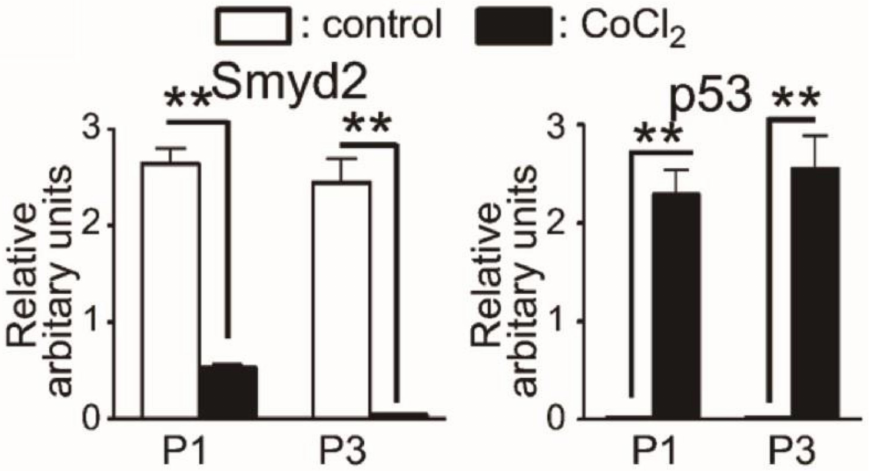
Figure 6. Cardiomyocytes, treated with CoCl2 to induce apoptosis, demonstrated downregulation of SMYD2 and accumulation of p53. **: ± SEM, n = 3. Adopted with permission from Elsevier Ref.